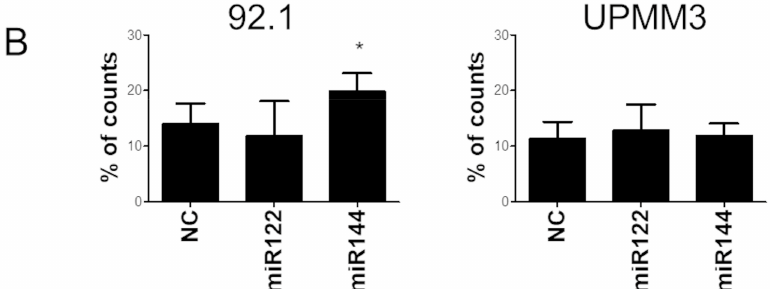
Figure 6. Flow-cytometric analysis of Annexin-V-PI staining of 92.1 and UPMM3 cells 72h after transfection with irrelevant miR (NC), miR122 or miR144 mimic. ( A ): a representative experiment is shown as dot plot; x -axis: Annexin-V-fluorescein isothiocyanate (FITC) staining, y -axis: Propidium Iodide (PI) staining. Viable cells take up no stains (lower left quadrant). Cells stained with PI alone are necrotic (upper left quadrant), cells stained only with Annexin-V-FITC constitute early apoptosis (lower right quadrant). Cells at final stages of apoptosis display both stains (upper right quadrant). Data are expressed as percentage of cells in each category. ( B ): Percentage of early apoptotic and apoptotic cells from three di ff erent experiments were used to calculate the mean ± sd of 92.1 and UPMM3 apoptotic cells (* p < 0.05). Cancers 2020 , 12 , x